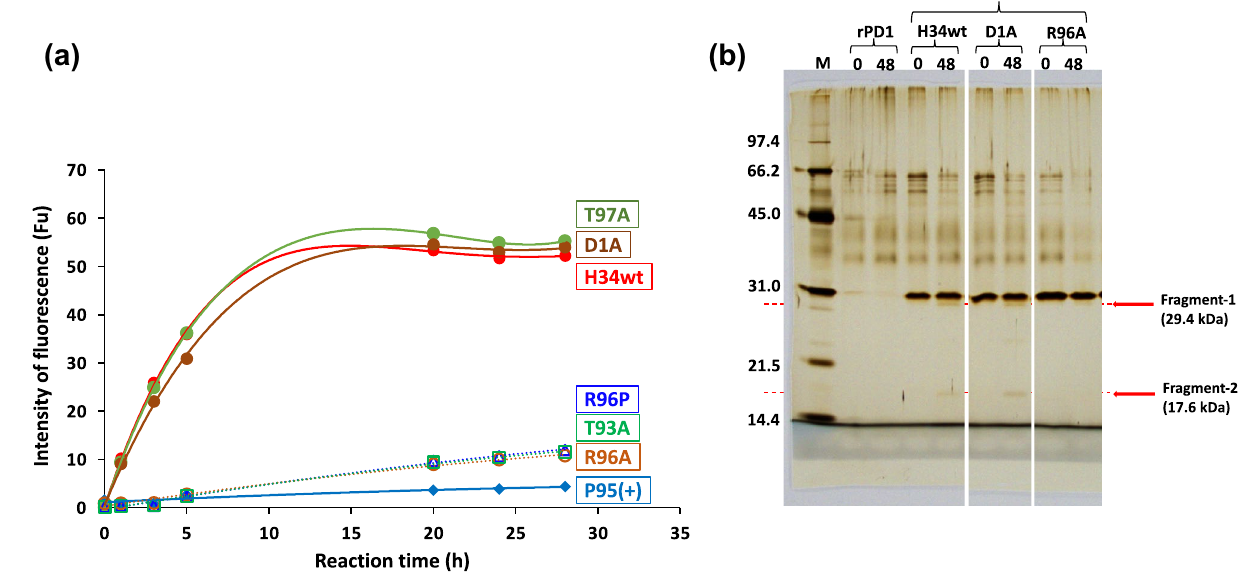
Figure 6. ( a ) Time course of the cleavage reaction for FRET-PD1 peptide by mutants. FRET-PD1: 25 µM. H34wt & mutants: 5 µM. In this experiment, H34wt was tested together with the mutants for ensuring accurate comparison among the samples. H34wt and the mutants of D1A and T97A show high catalytic activity. In contrast, three mutants of R95P, R95A, and T93A exhibit low catalytic activity. The catalytic activity of P95(+) is substantially suppressed. ( b ) Cleavage of recombinant PD-1 molecule. Recombinant PD-1 (rPD-1): 1 µM. H34wt, D1A, R96A and T97A: 0.5 µM. Reaction temperature: 37 °C. The SDS-PAGE (12% gel) experiment was performed under reduced condition, and the visualization was performed by silver staining. The cleavage reaction by H34wt and the several mutants were carried out over 48 h of incubation. The robust bands at approximately 29-kDa represent the monomer band of H34wt and/or the mutants. In H34wt light chain, a band at 17.5 kDa, which corresponds to the fragment of rPD1 (see ref.), is detected at 48 h of incubation; however, it is not detected at 0 h of incubation. Similar results are observed for D1A mutant, where the same band at 17.5 kDa is detected. In contrast, no band at 17.5 kDa is detected in the case of the mutant R96A, indicating that R96A does not cleave rPD-1. These results are consistent with the cleavage activity for FRET-PD1. Both H34wt and D1A, but not R96A, cleaves FRET-PD1 peptide with high